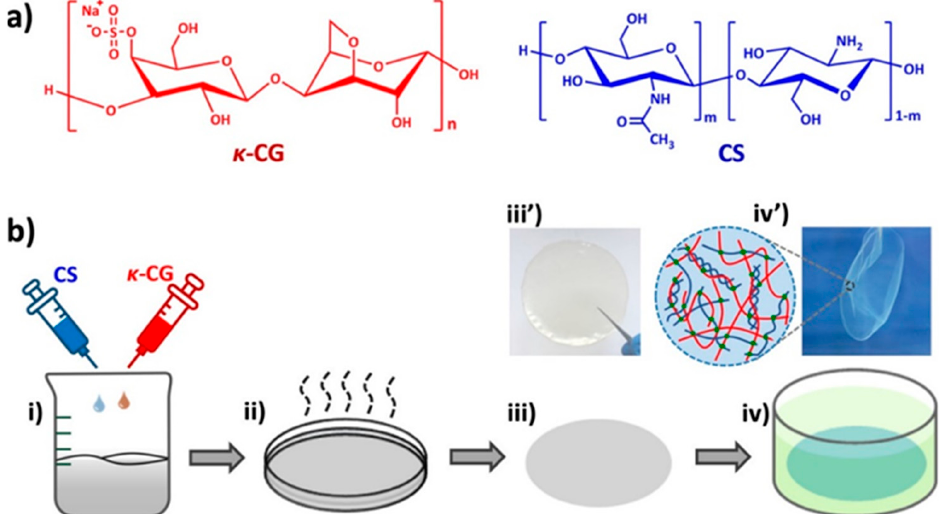
Figure 1. ( a ) Chemical structure of kappa-carrageenan (k-CG) and chitosan (CS). ( b ) The schematic representation on the preparation of ultra-thin κ -carrageenan/chitosan hydrogel films. Reprinted with permission from [30] Copyright 2018 American Chemical Society.